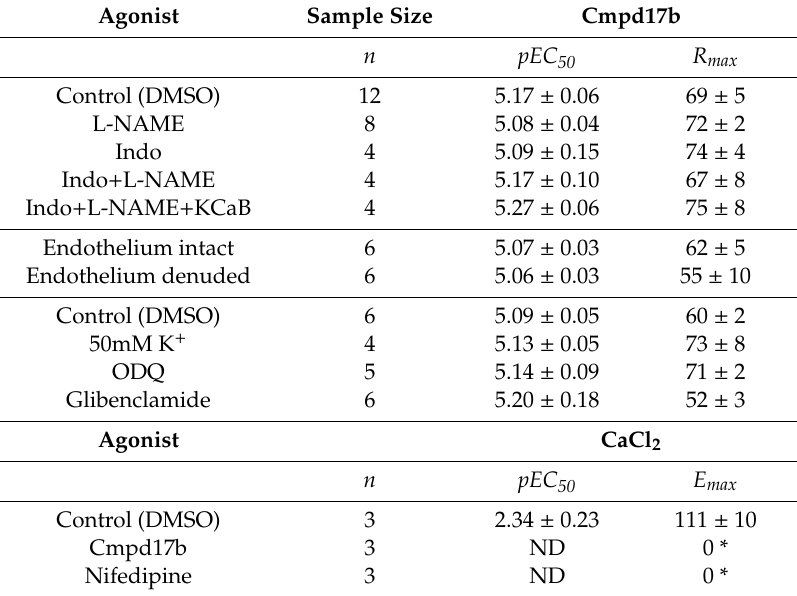
Table 1. E ff ects of various pharmacological inhibitors on vascular reactivity of Cmpd17b in the aorta. Agonist Sample Size